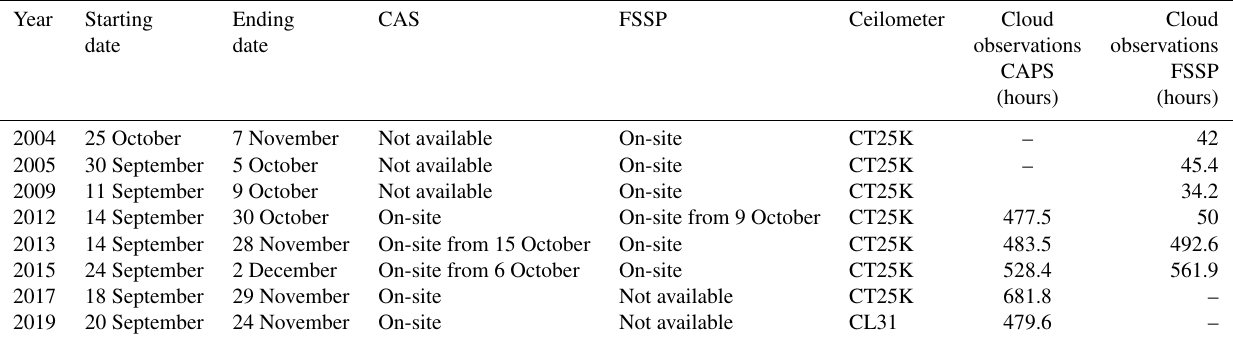
Table 2. Overview of each campaign, including the starting and ending date, the availability of the ground cloud spectrometer probes and the